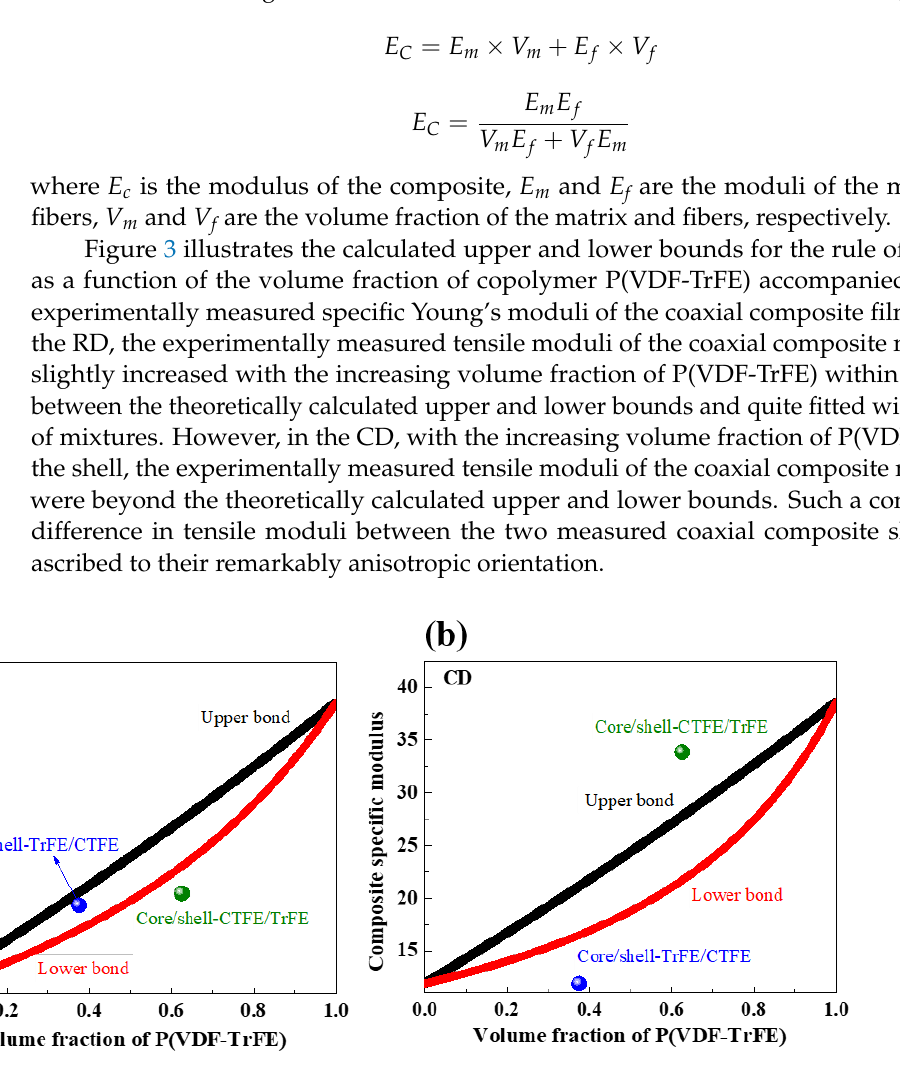
Figure 3. The upper and lower bounds calculated by the rule of mixtures accompanied with the experimentally measured specific Young’s moduli of the coaxial electrospun composite nanofibers in the ( a ) RD and ( b )